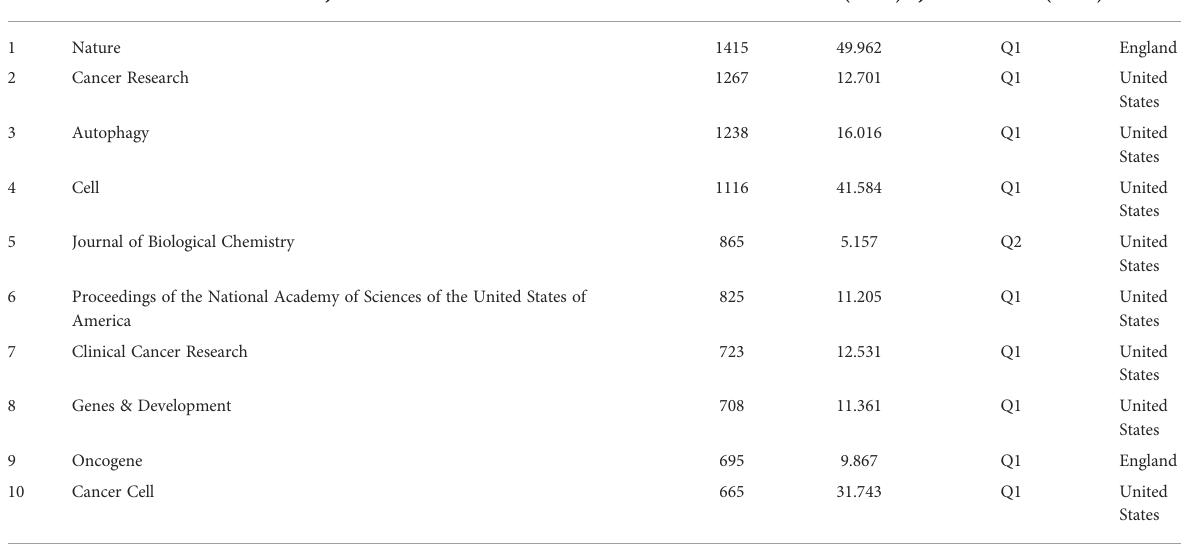
TABLE 4 The most co-cited journals associated with autophagy of pancreatic cancer. Rank